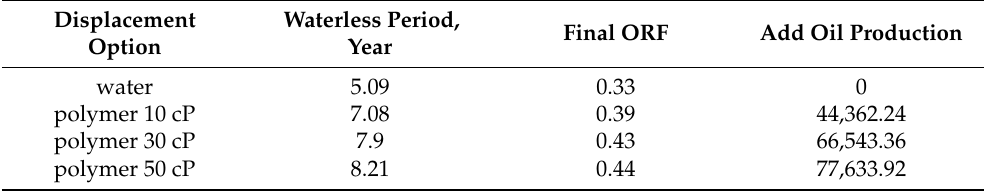
Table 3. Summary estimates for various oil displacement options.